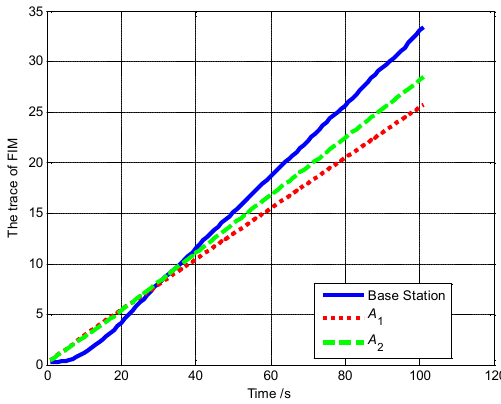
Figure 26. The track of the FIM for A 1 , A 2 and base station (Group B in Scenario 2).